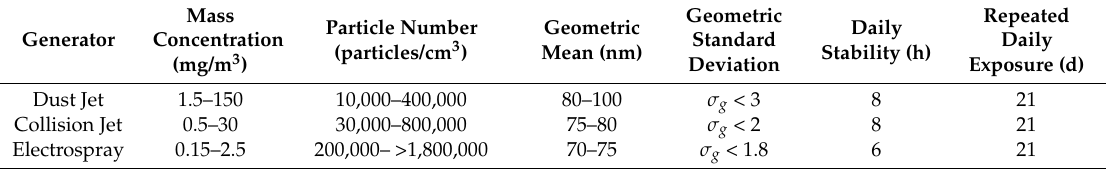
Table 1. Comparison of size distribution characteristics with the three aerosol generators tested.